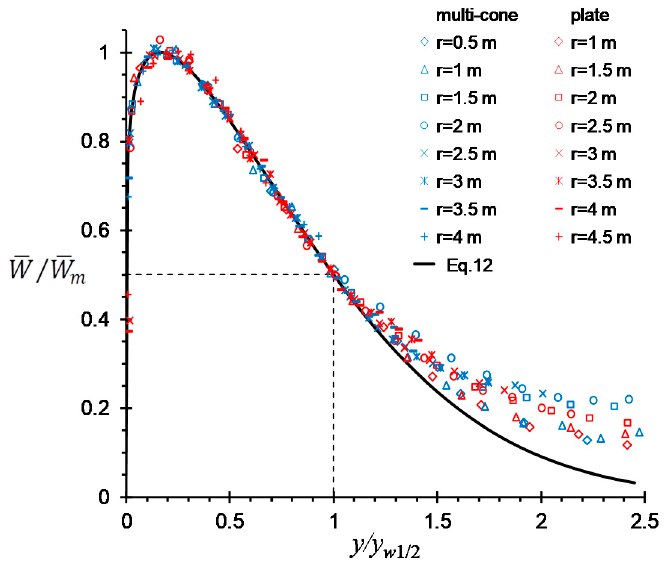
Figure 7. Distributions of the air speed in RWJs from the plate diffuser and the multi-cone diffuser. Table 2. The parameters of RWJs from multi-cone and plate diffusers for V o = 793 m 3 /h. The least-squares method was used to find the maximum mean speed 𝑊(cid:3365) (cid:3040) and the half-width of the jet 𝑦 (cid:3050)(cid:2869)/(cid:2870) . Equations (10) and (11) were used to find the maximum mean velocity 𝑈(cid:3365) (cid:3040) and the half-width of the velocity profile 𝑦 (cid:3048)(cid:2869)/(cid:2870) . To calculate jet momentum flux 𝑀 𝜌⁄ , the equation obtained by the numerical integration of 𝑈(cid:3365) (cid:3045)(cid:2870) distribution in the range from η u = 0 to η u = 1.94 was used, Equation (12). The results are presented in Table 2.